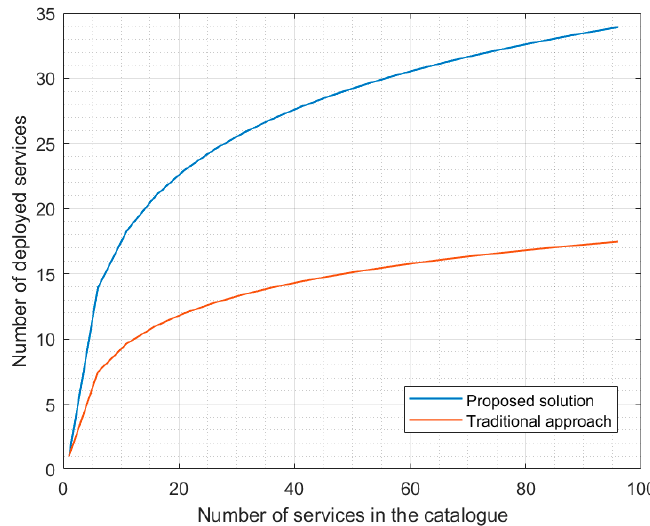
Figure 6. First experiment: number of deployed services.